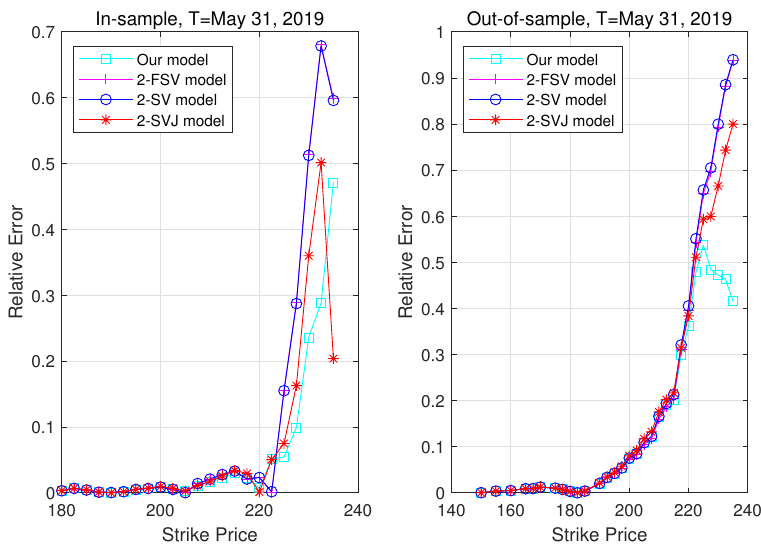
Figure 2. The comparison of predicted prices of four model specifications and market prices on 9 May 2019, with maturity T = 31 May 2019.